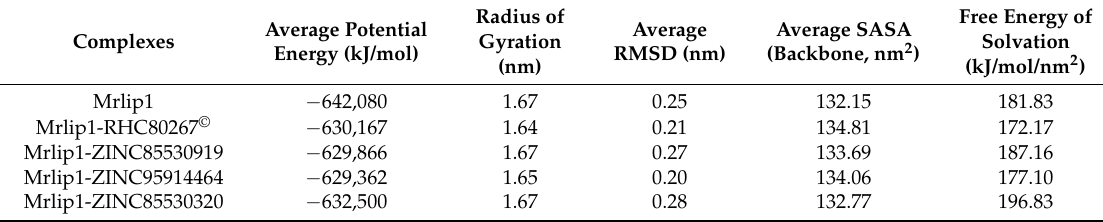
Table 4. The calculated parameters for all the system obtained after 100 ns MD simulations.